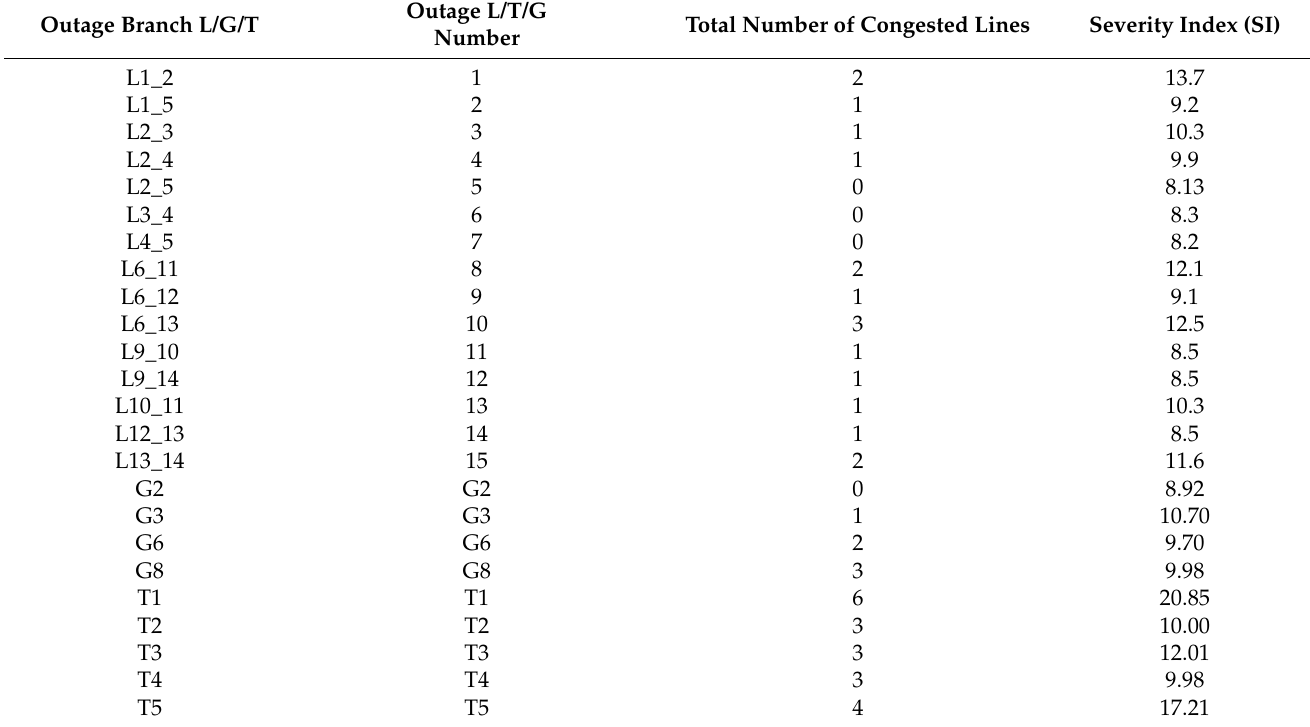
Table 2. Number of congested lines and severity index (SI) for various outage cases in the modified IEEE 14-bus